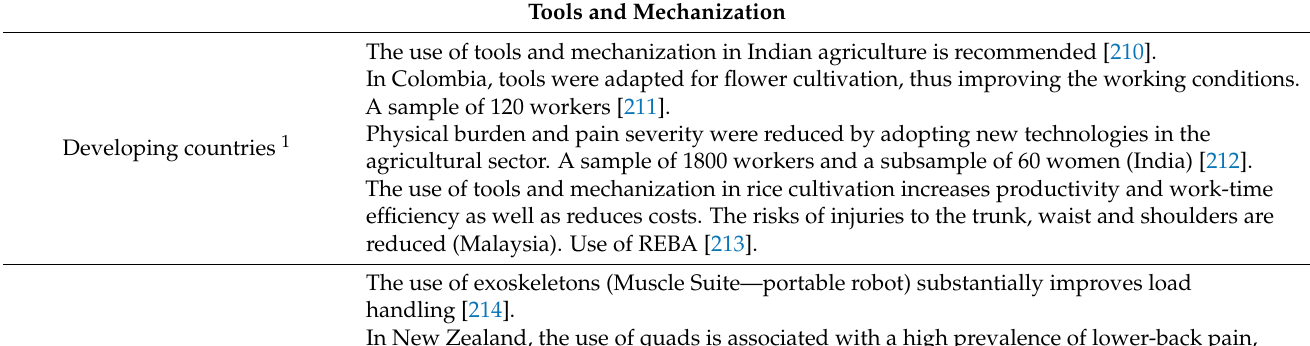
Developing countries 1